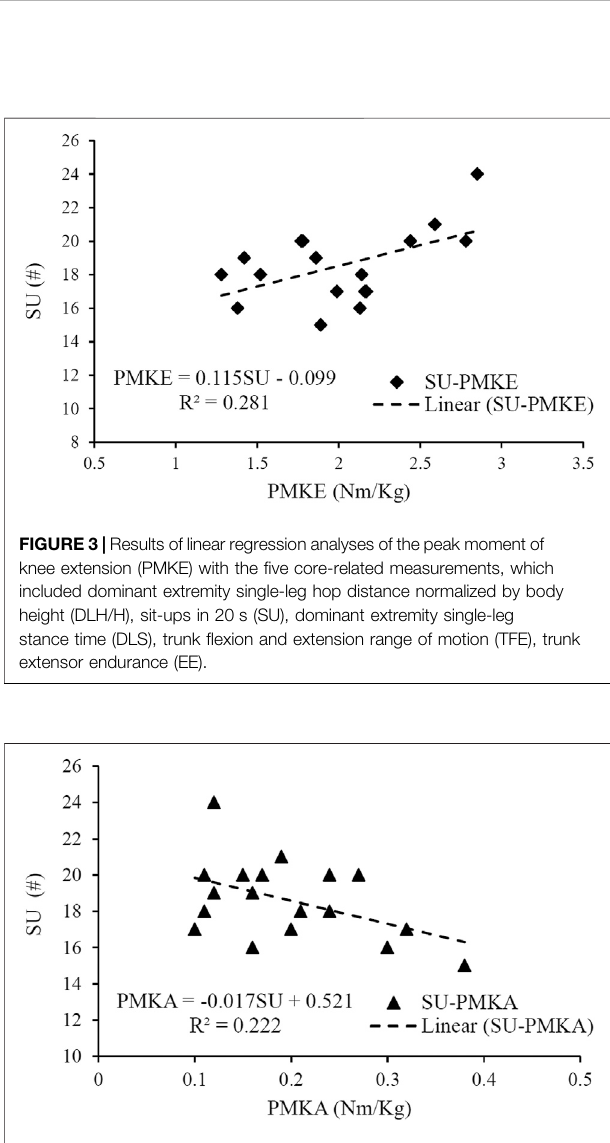
FIGURE 4 | Results of linear regression analyses of the peak moment of knee abduction (PMKA) with the fi ve core-related measurements, which included dominant extremity single-leg hop distance normalized by body height (DLH/H), sit-ups in 20 s (SU), dominant extremity single-leg stance time (DLS), trunk fl exion and extension range of motion (TFE), trunk extensor endurance